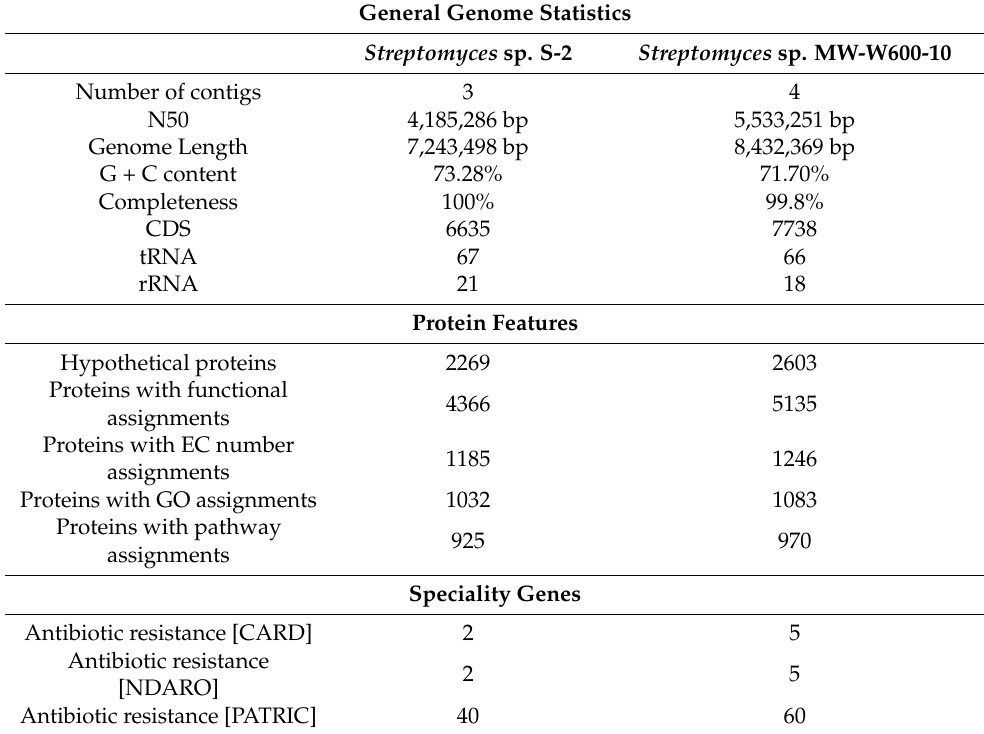
Table 1. Next-generation sequencing of statistical data and comparison of genome features of the coal-related environment of Streptomyces strain’s draft